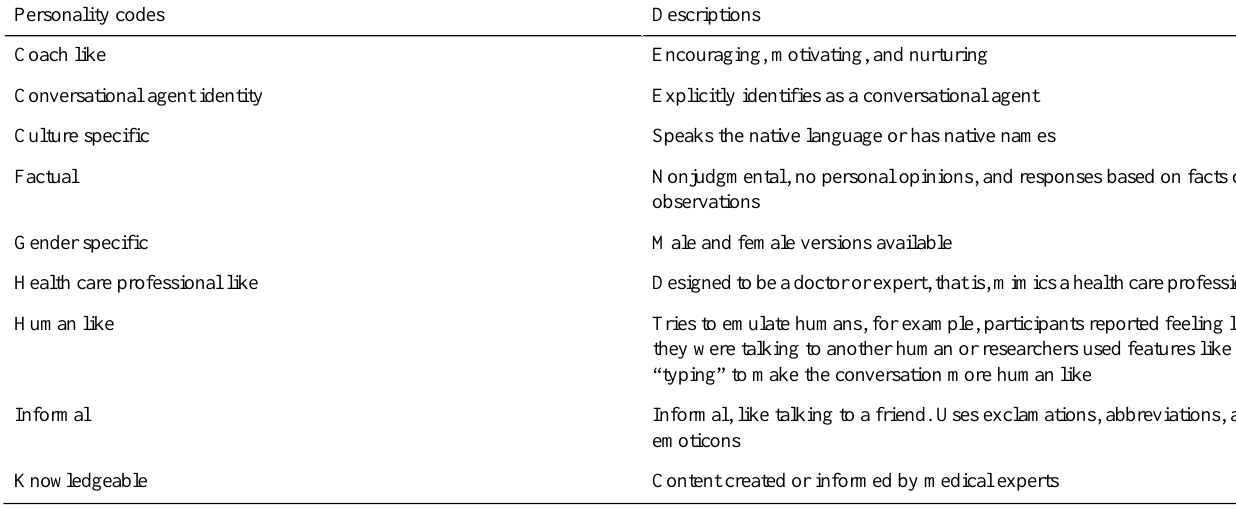
Table 1. Personality codes derived for the conversational agents included in this review, adapted from Haan et al. DescriptionsPersonality